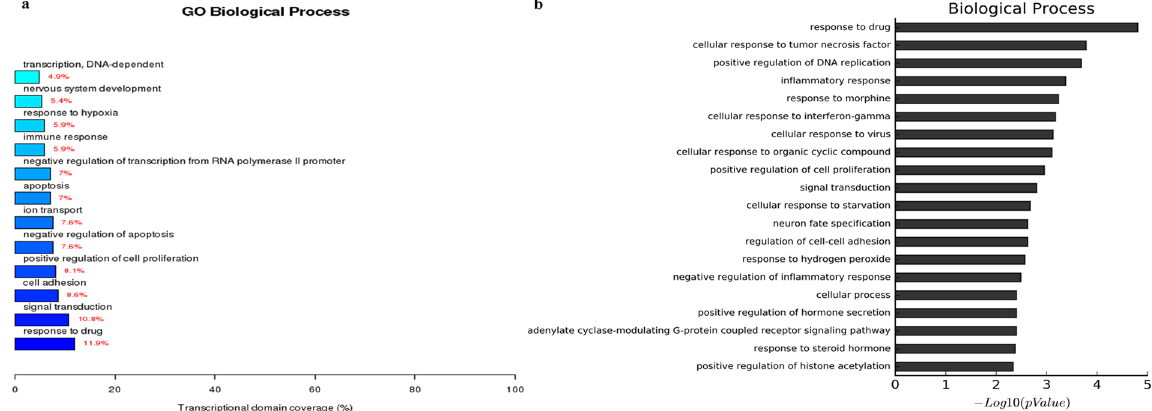
Figure 8. The RCCS-3D vs static-3D group comparison that gene ontology analysis of differentially expressed genes in biological process. ( a ) Top 20 terms based on most significant p value of biological processes. ( b ) Top 12 terms based on the differential genes were most extensive transcriptional domain coverage.